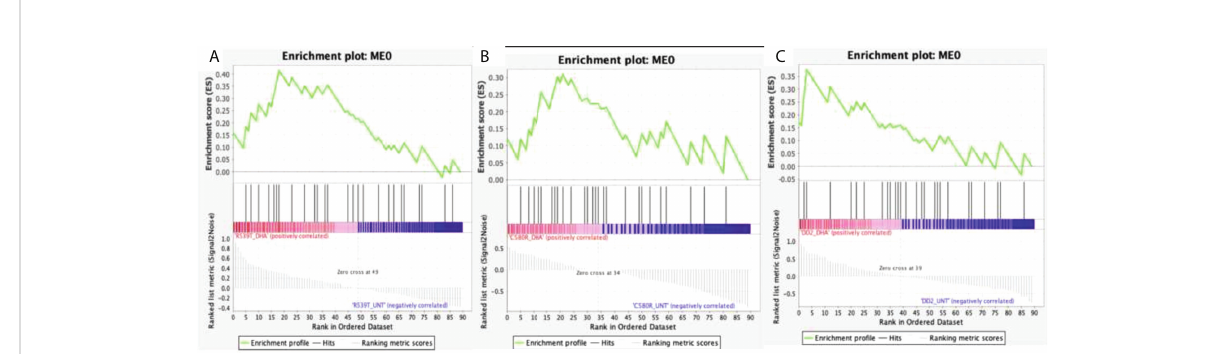
FIGURE 2 Enrichment score behavior showing the distribution of module 0 (ME0) in the input list of ranked genes for the three compared treatment conditions with FDR q-value < 0.25. Module 0 is the EVs module of interest comprising 693 genes with correlated expression with the PF3D7_1441800 gene (PfVps60) and PF3D7_0816200 (PfVps2) involved in EVs biogenesis in P. falciparum . The enrichment plots were generated by GSEA. Enrichment scores (ES) were calculated by strolling down the input list of ranked of genes, increasing a running-sum statistic when a gene is in ME0 and decreasing it when it is not. The magnitude of the increment depends on the correlation of the gene with the treatment condition. The ES is the maximum deviation from zero encountered in walking the list. The normalized enrichment score (NES) is calculated by normalizing the enrichment score for gene set size and represents the association of the modules with the treatment conditions compared. A positive NES indicates module enrichment and association with the fi rst treatment condition. The higher the NES the stronger the association with the module. False discovery rate (FDR) was used to correct for multiple testing. Statistical signi fi cance was designated at an FDR q-value < 0.25. (A) R539T_DHA_treated versus R539T_untreated condition; ME0 was upregulated in the R539T_DHA_treated condition (NES = 1.18, FDR q-value = 0.24). (B) C580R_DHA_treated versus C580R_untreated; ME0 was upregulated in the C580R_DHA_treated condition (NES = 1.25, FDR q-value = 0.14). (C) DD2_DHA_treated versus DD2_untreated; ME0 was upregulated in the DD2_DHA_treated condition (NES = 1.18, FDR = 0.23). ME0, module 0; ES, enrichment score; NES, normalized enrichment score; FDR, False discovery rate; GSEA, gene set enrichment